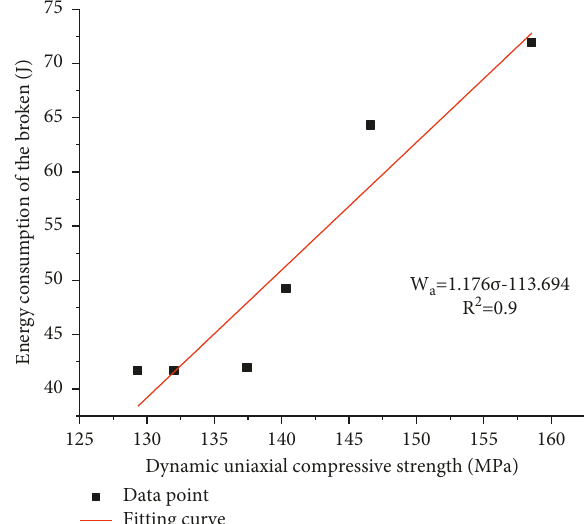
Figure 10: Fitting curve of crushing energy consumption-dynamic compressive strength.